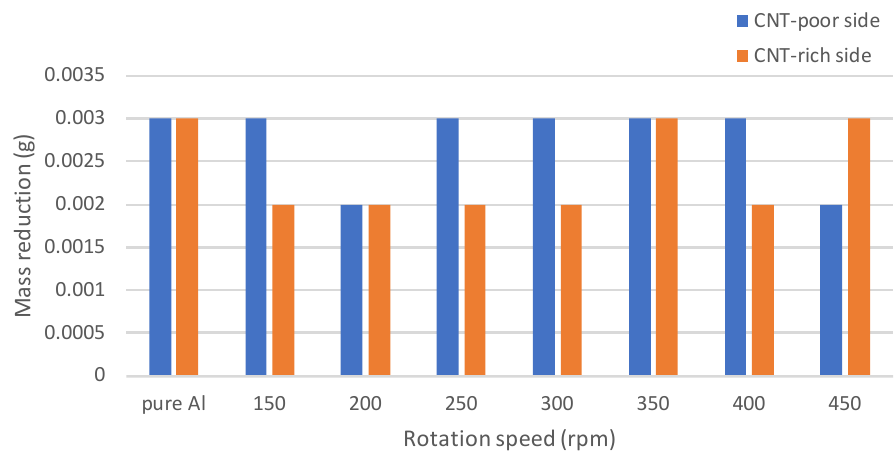
Figure 11. Mass reduction of samples of FGMs with the rotation speeds from 150 to 450 rpm.